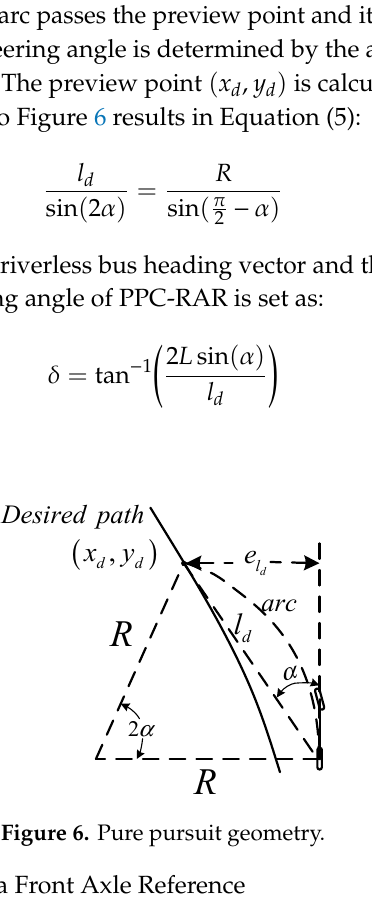
Figure 5. The structure of the lateral controller.